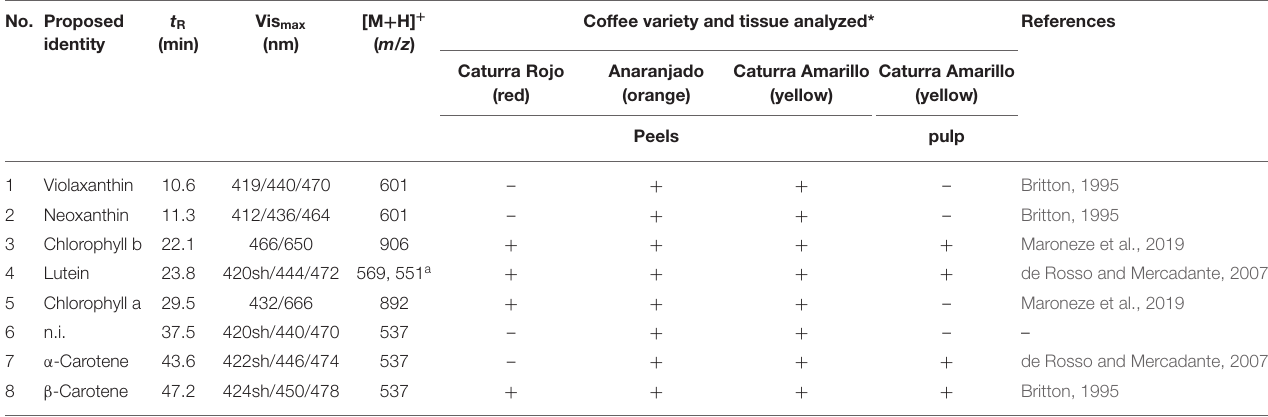
)-MS data and qualitative carotenoid and chlorophyll profiles in the peels of three coffee varieties and + Coffee variety and tissue analyzed*